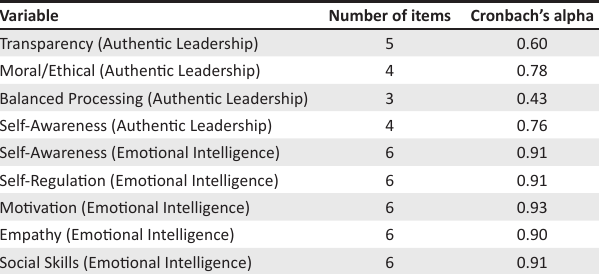
TABLE 3: Reliability estimates.